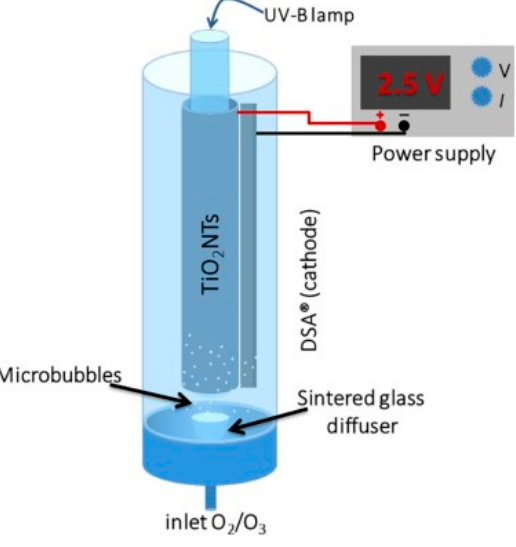
Figure 10. Schematic representation of the PEC annular bubble column reactor. (Reproduced with permission from [47]: Kim, J.Y.U.; Bessegato, G.G.; de Souza, B.C.; da Silva, J.J.; Zanoni, M.V.B. Efficient treatment of swimming pool water by photoelectrocatalytic ozonation: Inactivation of Candida parapsilosis and mineralization of Benzophenone-3 and urea. Chem. Eng. J. 2019 , 378, 122094; DOI:10.1016/j.cej.2019.122094. Copyright (2019), Elsevier (Amsterdam, The Netherlands)).